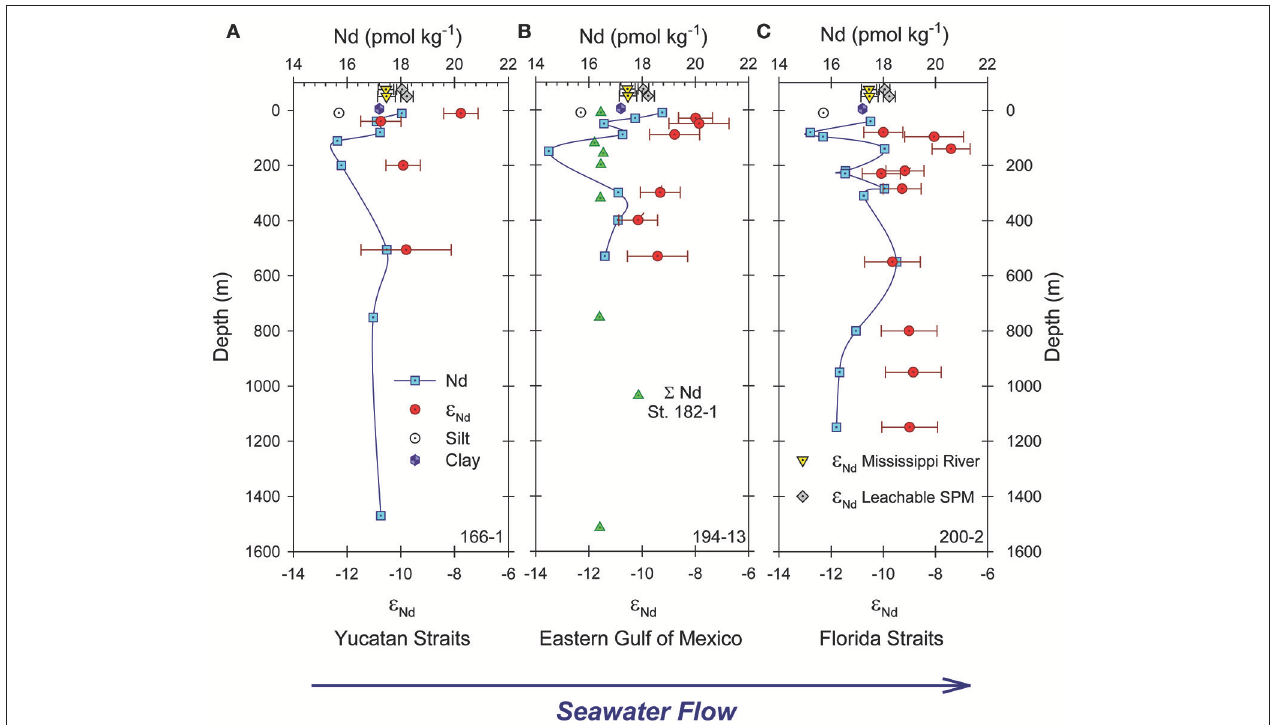
FIGURE 9 | Neodymium concentrations (blue squares) and ε Nd(0) (red circles) for water column samples from stations 166-1, 194-13, and 200-2 shown in Figure 8 (data from Osborne et al., 2014, 2015). Green triangles in (B) are Nd concentrations for station 182-1 ( Figure 8 ; Osborne et al., 2015). Yellow inverted triangles and gray diamonds plotted above 0m depth in each panel are ε Nd(0) ± 2 σ for Mississippi River (MR) water and the labile fraction of the associated SPM, respectively, measured in this study ( Table 5 ). The open circle and purple hexagon show ε Nd(0) values for the silt and clay fractions of sediments at the mouth of the MR ( Bayon et al.,